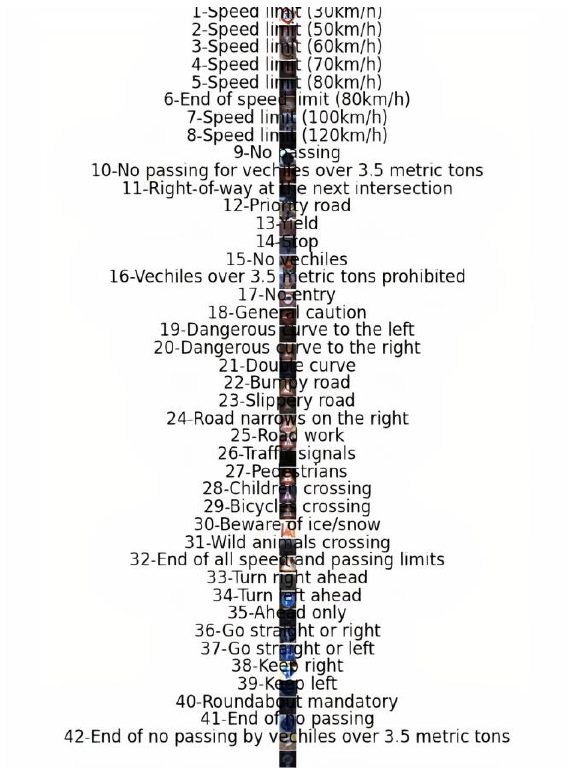
Fig. 8. Classes with their corresponding images Fig. 8, gives a brief Idea about all the Images Present in the Dataset with Their corresponding classes marked by Class-ID. Division of data into train, test and validate set is performed. Neural networks expect the labels of classes in a dataset to be organized in a one-hot encoded manner. Conversion of labels into one hot encoding is also executed .